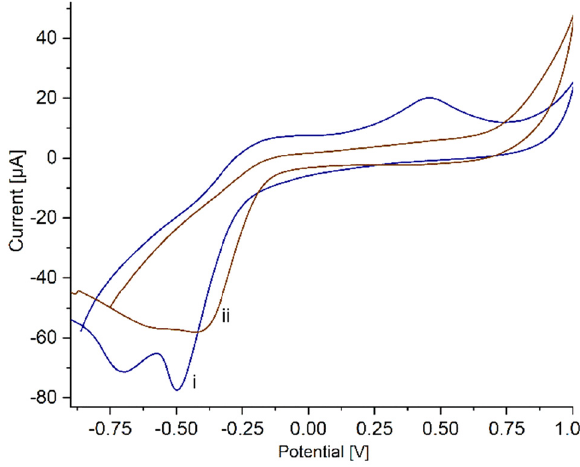
Figure A4: Cyclic voltammetry of ( i ) SPCE/PAni/AuNP/cMWCNT/CAT and ( ii ) SPCE/AuNP/cMWCNT/CAT in PBS 0.01 M in presence of H 2 O 2 2 mM at 20 mV s − 1 .